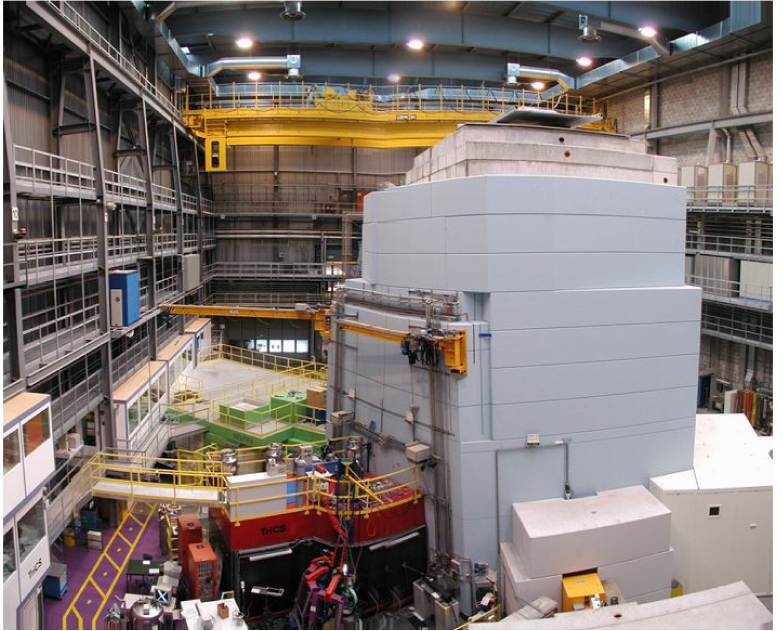
Figure 8. Overview of the SINQ installation; the green area on the left side is the NEUTRA imaging facility, where the NEURAP experiments have been performed, NEURAP is placed from the roof.